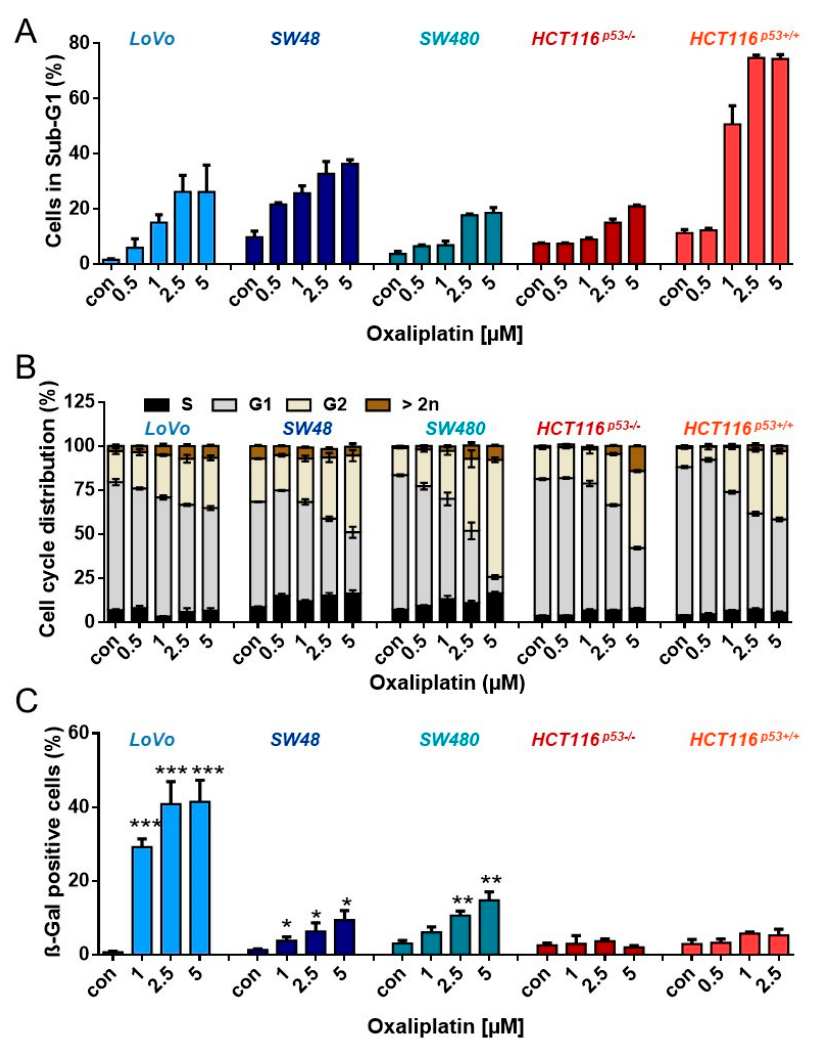
Figure 3. ( A ) Cell death and ( B ) cell cycle distribution was measured by flow cytometry 168 h upon exposure to different concentrations of oxaliplatin in PI-stained CRC cells. ( C ) Senescence was measured microscopically by detection of β -Gal positive cells 168 h after oxaliplatin exposure. ( A – C ) Experiments were performed in triplicates and differences between treatment and control were sta- tistically analyzed using Student’s t test (not labeled = not significant, * p < 0.1, ** p < 0.01, *** p < 0.001). Concerning cell cycle distribution, at concentrations > 2.5 µM, a significant (* or **) decrease of cells in G1 and increase in the G2-phase was observed.